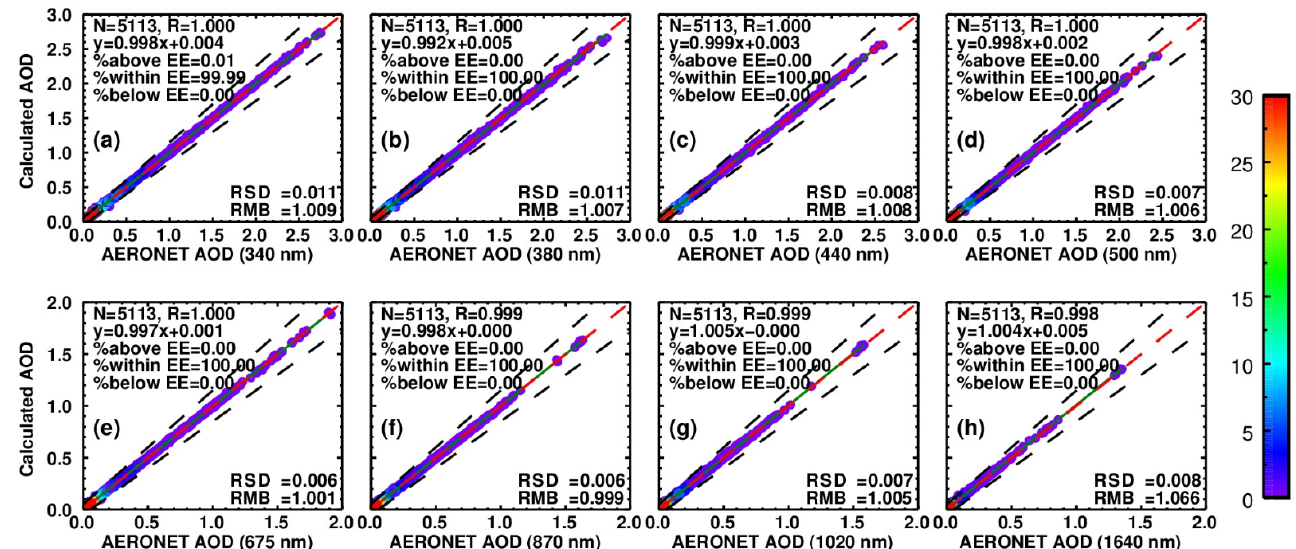
Figure 9. Validation of the calculated AOD at each wavelength (from 340 to 1640 nm ( a – h )) against the AERONET AOD. The one-to-one line, the linear regression line and the expected error envelopes of ±(0.05 ± 10%) are plotted as dashed red, solid green and dashed black lines, respectively. To present the distribution of the discrepancy in more detail, the calculated AOD values were compared with the equal-frequency bins of the reference AOD from AERO- NET. Figure 10 shows all the calculated AOD values sorted into ascending order and then sampled with 20 bins. The AOD bias for the visible and near-infrared wavelengths varied from −0.02 to 0.02, with the mean biases (red dots) concentrated within ±0.01. The biases for the ultraviolet bands were higher and varied in a broad range from −0.02 to 0.03 and